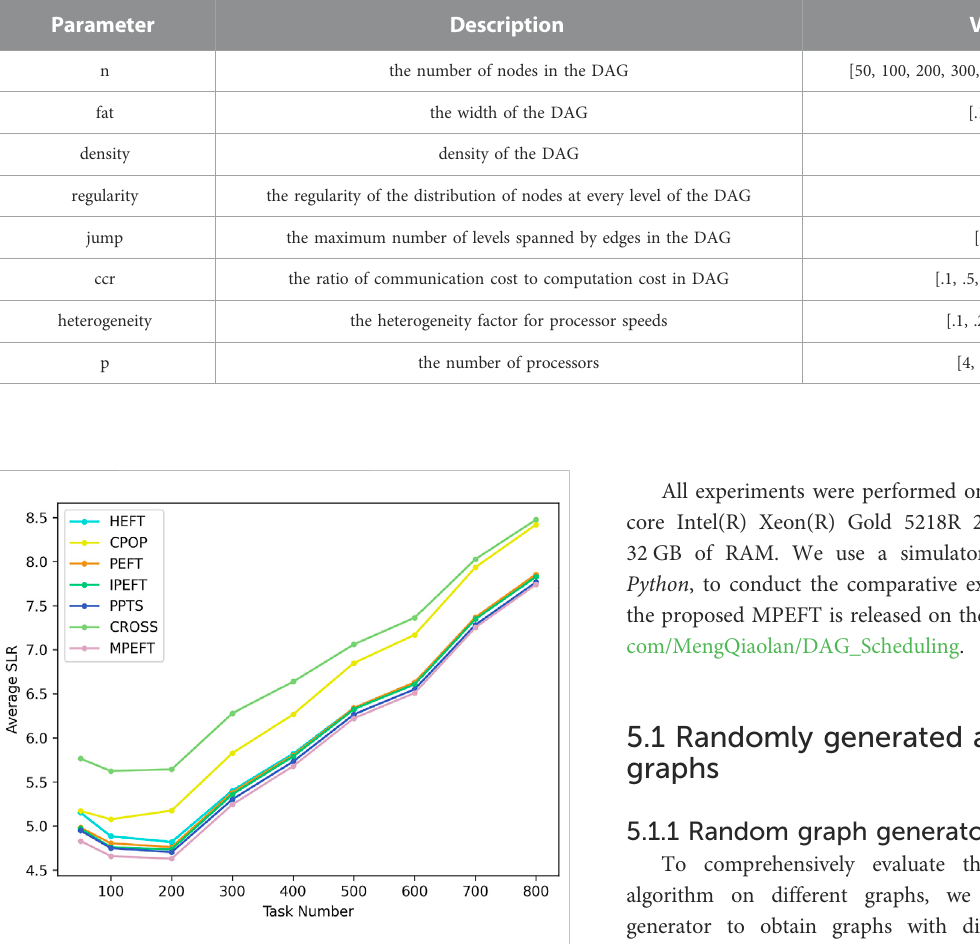
FIGURE 4 Average SLR for random graphs with respect to DAG